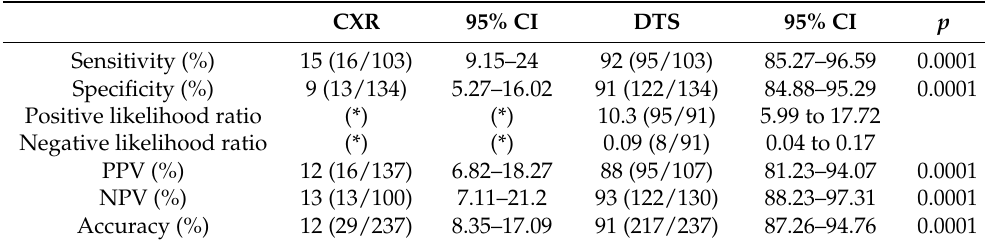
Table 2. Diagnostic performance. (*): Due to a sensitivity and specificity <50%, positive and negative likelihood ratios were not